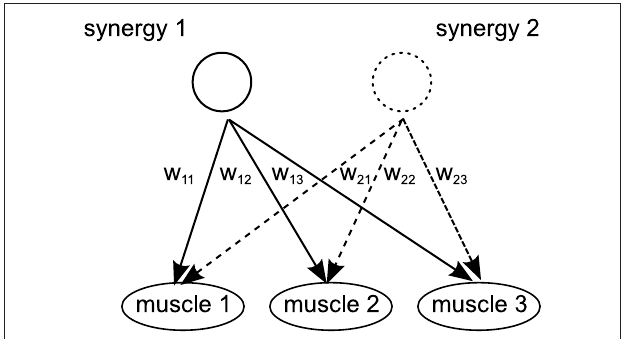
FIGURE 1 | Concept of motor synergies. One motor synergy constitutes particular grouping of muscles for certain weights confi gurations (Bizzi and Clarac, 1999). In the same time, one muscle can be activated by several synergies (Ting, 2007); this demonstrates how modular and fl exible the motor system